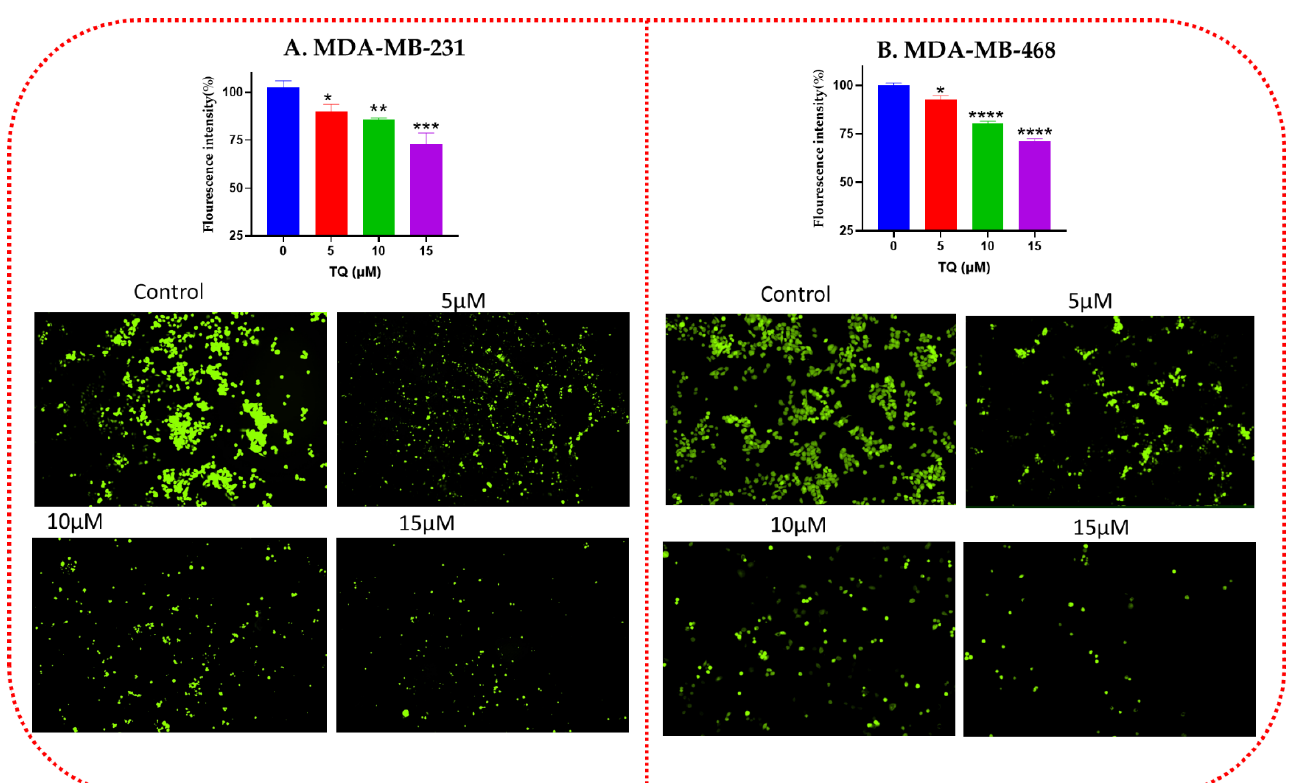
Figure 2. The intracellular level of ROS in TQ-treated MDA-MB-231 ( A ) and MDA-MB-468 ( B ) TNBC cells. The effects of TQ on the intracellular ROS level of TNBC cells were examined by DCFH-DA assay. TNBC cells were treated with different concentrations of TQ (5–15 µM) for 24 h, followed by 45 min incubation period with 10 µM DCFDA. TQ significantly reduced the ROS level compared to control groups in a concentration-dependent manner. A Synergy HTX Multi-Mode microplate reader (BioTek Instruments, Inc., Winooski, VT, USA) was used to measure ROS fluorescence. The green fluorescence of the reacted DCFH-DA, which indicates the ROS level, was observed with fluorescence microscopy using Nikon inverted microscope eclipse (NY 11747-3064, USA). Three independent experiments/3 replicates each was conducted to generate the data and presented as mean ± SEM. Asterisks indicate a significant reduction in ROS level compared with control cells only (* p < 0.05, ** p < 0.01, *** p < 0.001, **** p < 0.0001). ROS, reactive oxygen species;